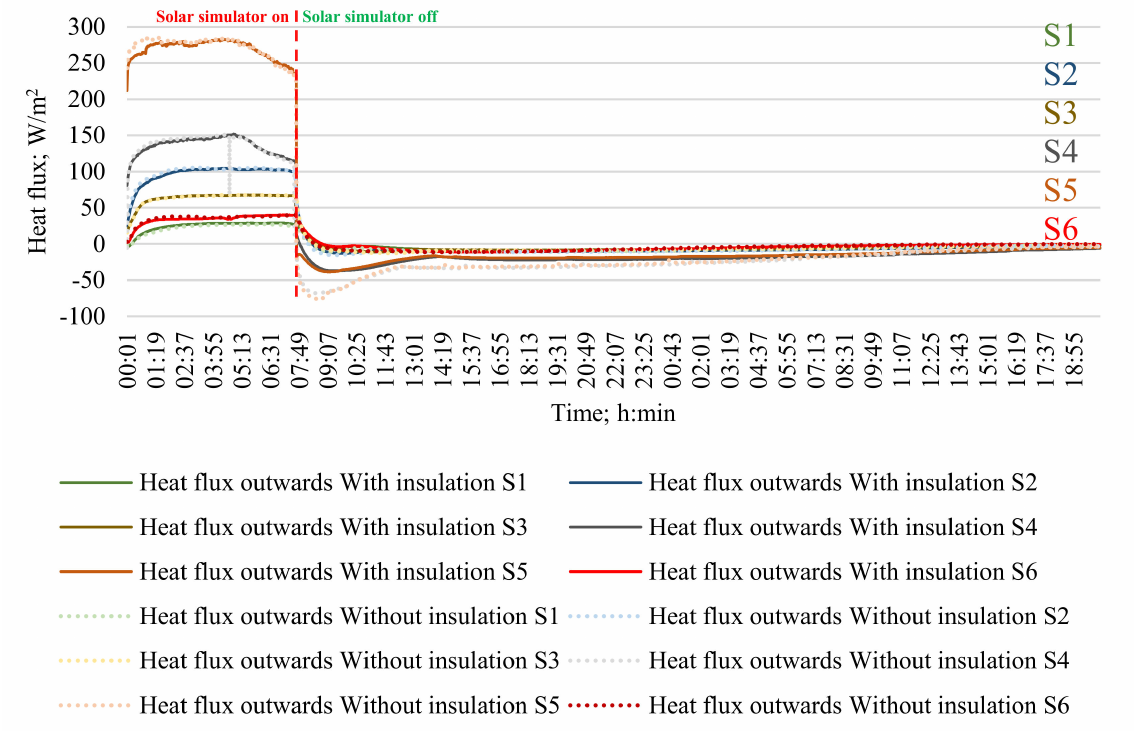
Figure 13. Outward heat flux comparison in all of the Setups with (W) and without (W/O) an adjustable insulation